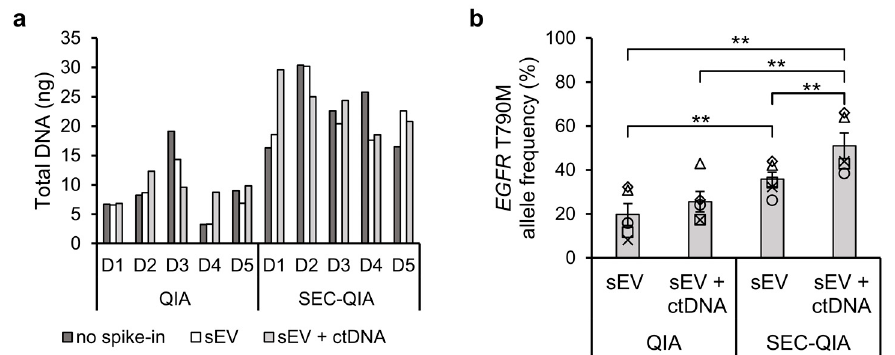
Figure 4. EGFR T790M enrichment in cell-free DNA extracts of human plasma extracted with the QIAamp Circulating Nucleic Acid kit (QIA), directly, or after separation of sEV fractions by SEC (SEC-QIA). ( a ) Concentration of total DNA in plasma samples from 5 healthy donors (D1-5) without spike-in (no spike-in), spiked with 1 × 10 8 sEVs/mL plasma (sEV), or with sEVs in combination with 300 copies short EGFR T790M DNA fragments (sEV + ctDNA) using the HS DNA assay on a Qubit 2.0 Fluorometer. ( b ) EGFR T790M allele frequency in sEV and sEV + ctDNA samples obtained by ddPCR. Data are represented as mean ± SEM (N = 5, n = 2) of N donors, each indicated by an open symbol. Statistically significant results are indicated by ** for p -value ≤ 0.01.